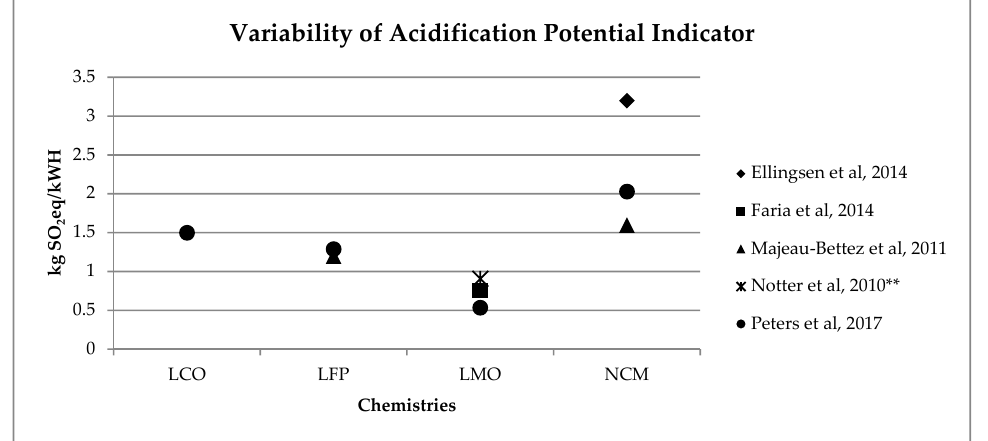
associated with battery production does not affect the environmental ranking among EV and the corresponding ICE Vehicle. For categories like acidification, the use of the lower bound value implies that EV performs better than ICE Vehicle, while the use of the upper bound value implies that the ICE Vehicle is the best performer (see Table 4).